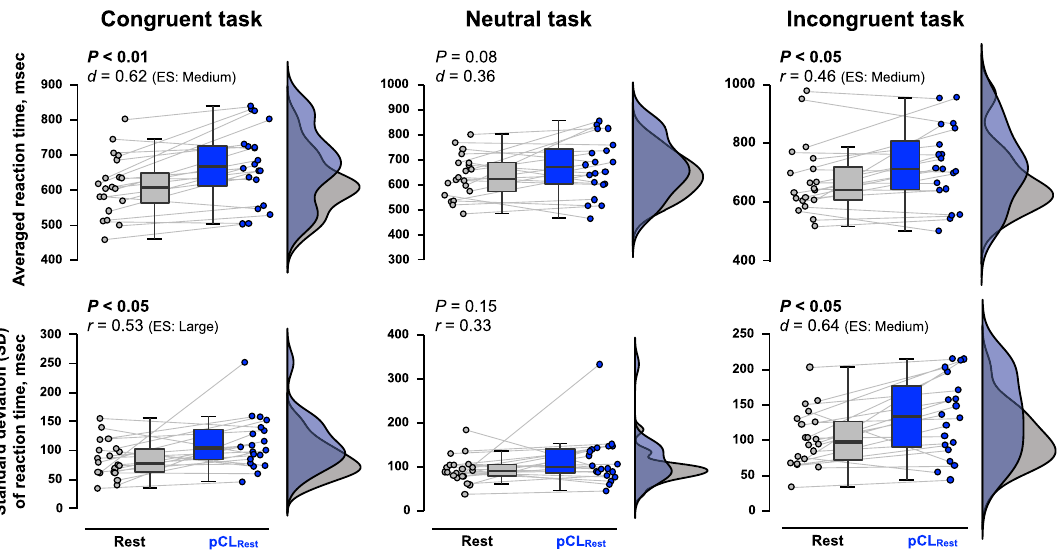
Figure 3. The reaction time (RT) of colour-word Stroop task (CWST) during the last 5 min of Rest (gray) and pCL Rest (blue) conditions. Raincloud plots showing the distribution of RT data. Circle plots represent individual data, and box-and-whisker plots are median (IQR and max/min). The upper illustrations are the averaged data during 5-min collection, while the lower illustrations are the SD during 5-min data collection.